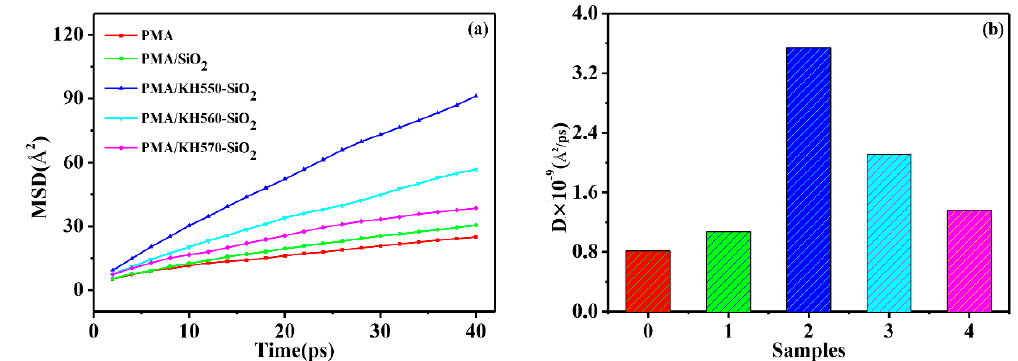
Figure 14. ( a ) MSD diagrams of H 2 O in the PMA, PMA/SiO 2 , PMA/KH550-SiO 2 , PMA/KH560-SiO 2 , and PMA/KH570-SiO 2 films during the 40-ps MD duration, ( b ) The diffusion coefficient (D) of H 2 O in composite system: 0. PMA, 1. PMA/SiO 2 , 2. PMA/KH550-SiO 2 , 3. PMA/KH560-SiO 2 , and 4. PMA/KH570-SiO 2 .